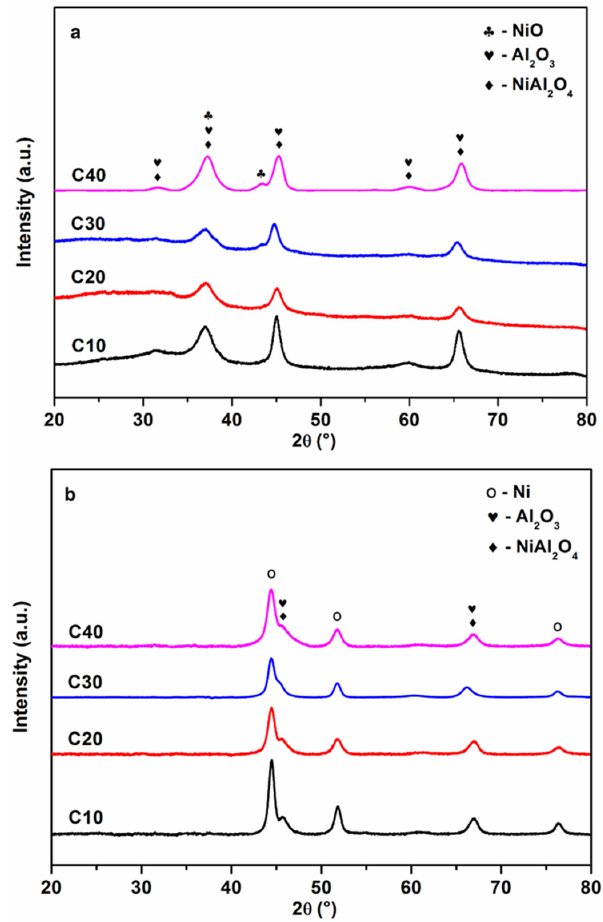
Figure 6. XRD patterns of the catalysts with different metal ion contents: ( a ) Before reduction; ( b ) after reduction at 750 °C for 1 h.